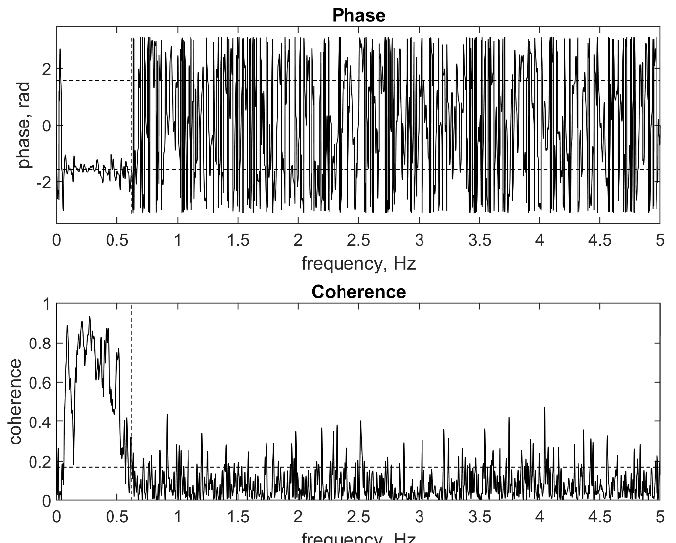
Figure 1. Phase and coherence plots from u-w co-spectral analysis of field data. The dashed lines in the phase plot indicate phases of ± π /2 and in the coherence plot, it indicates the level of statistically significant coherence. The red dashed lines indicate the selected cut-off frequency between wave motions and turbulence (in this case f = 0.62 Hz).